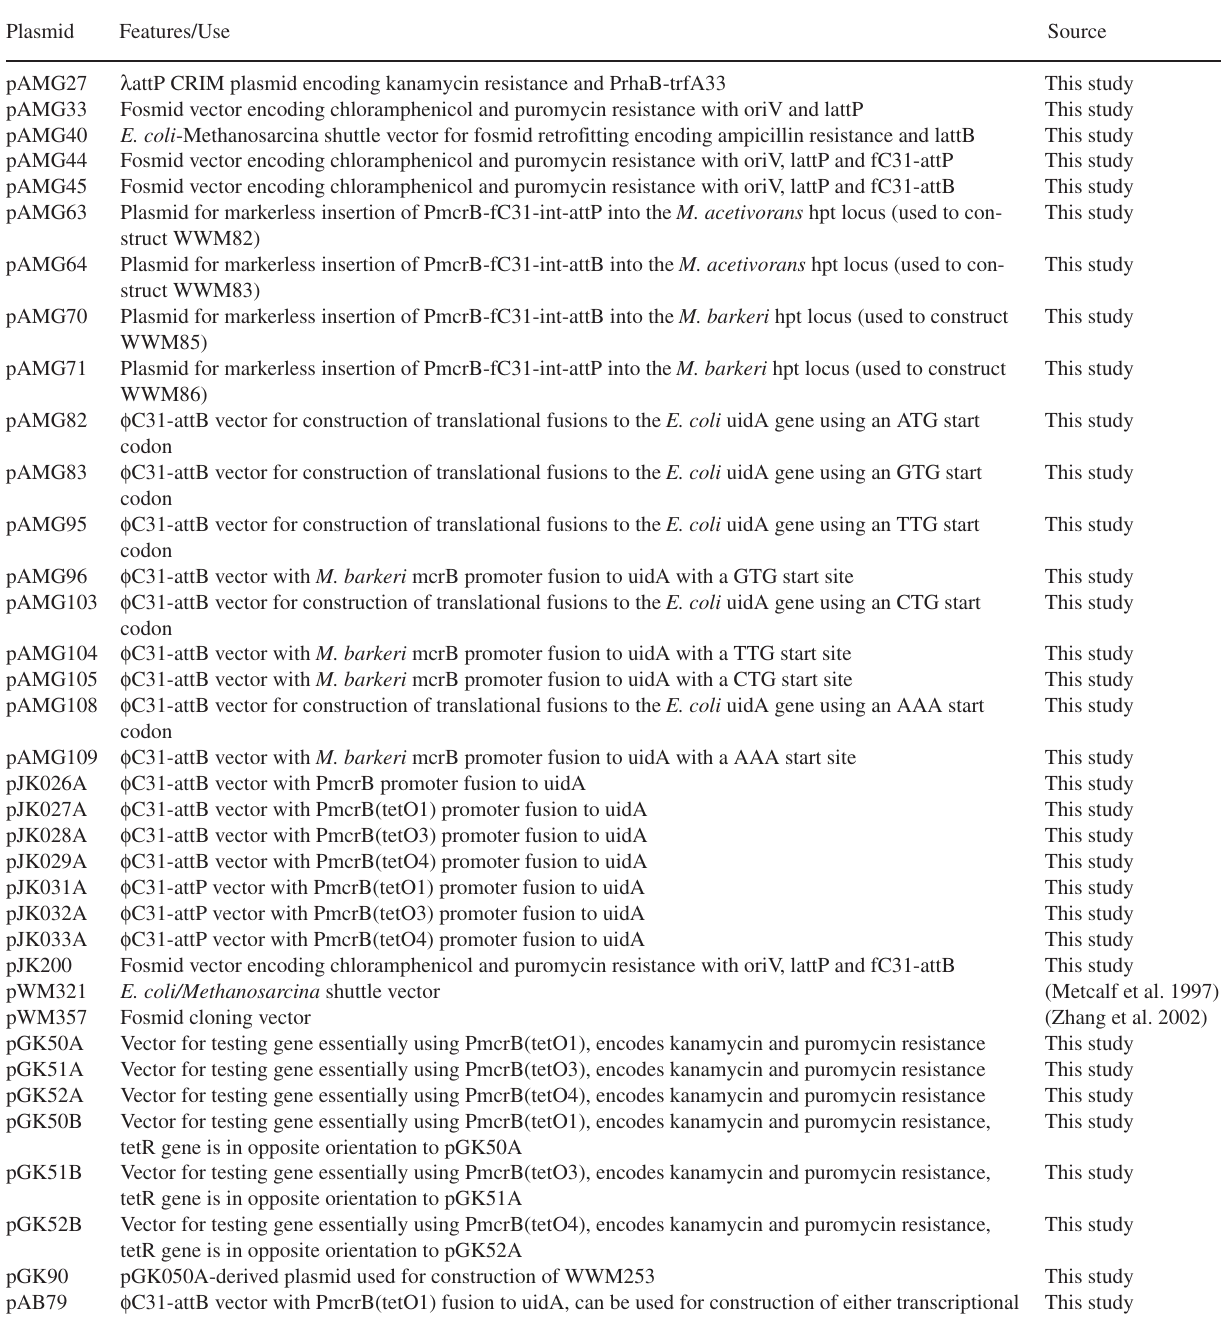
Table 2. Plasmids and primers used in the study. Plasmid